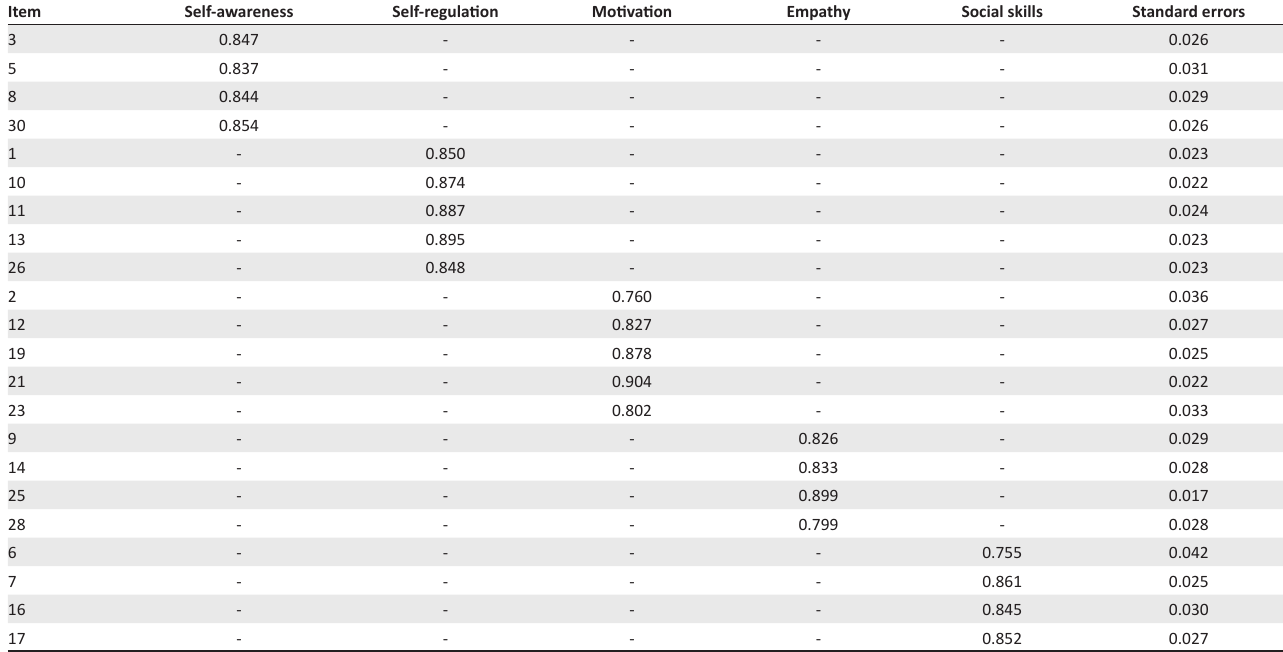
TABLE 6: Standardised solution (Sample 2, n = 308).